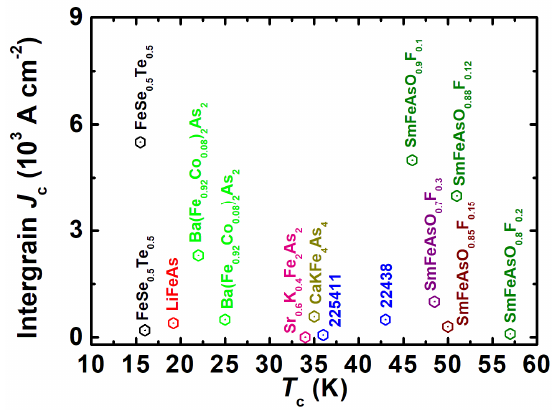
Figure 3. The transition temperature ( T c ) dependence of the intergrain J c calculated from the remanent magnetization measurements for different FBS families together with that of the 1111 and 1144 families. All the mentioned samples are prepared by the conventional synthesis process at ambient pressure (CSP-AP). The data were gathered from the references [11,16,30,32,37,107–110].